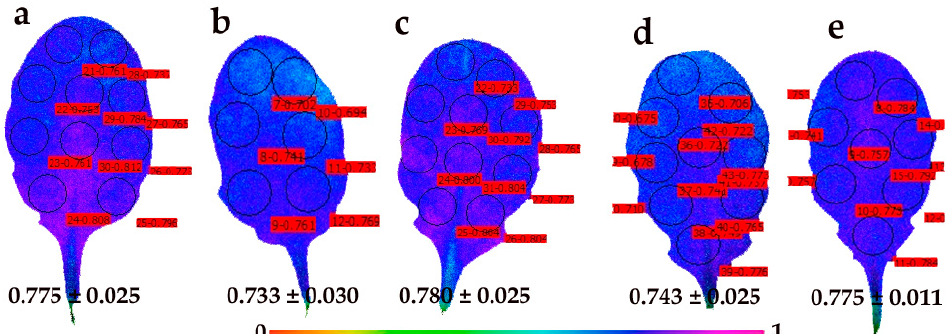
Figure 9. Representative chlorophyll fluorescence images of the relative reduction state of the plastoquinone (PQ) pool, that is, the photochemical fluorescence quenching, reflecting the fraction of open PSII reaction centers ( q p ), of Arabidopsis thaliana young leaves after 5 min of illumination at 140 µ mol photons m − 2 s –1 . Leaves were measured after the foliar spray with distilled water (control) ( a ), or 30 min ( b ), 90 min ( c ), 180 min ( d ), and 240 min ( e ) after the foliar spay with 30 mg L − 1 of CuZn NPs. The color code depicted at the bottom of the images ranges from values 0.0 to 1.0. The areas of interest (AOI) are shown in each image. The average q p value of all the AOI for the whole leaf is shown.